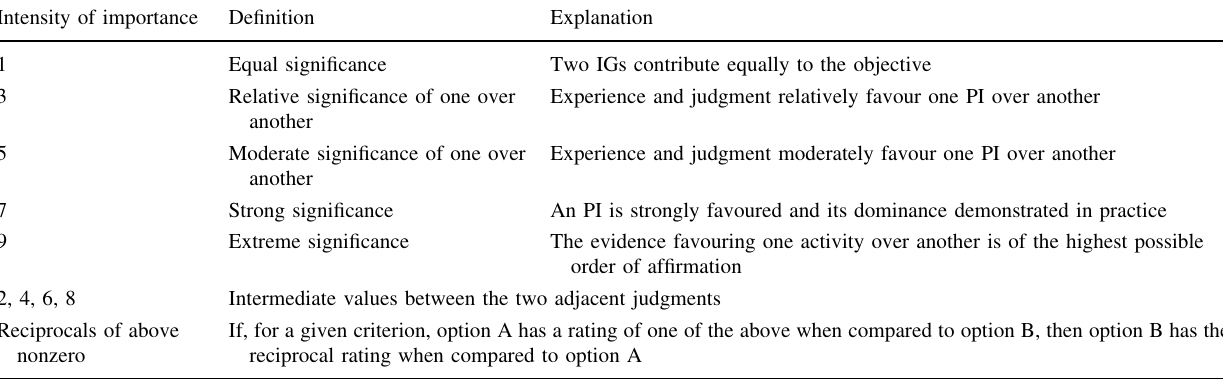
Table 3 Judgment matrix of an expert for PIs in AHP